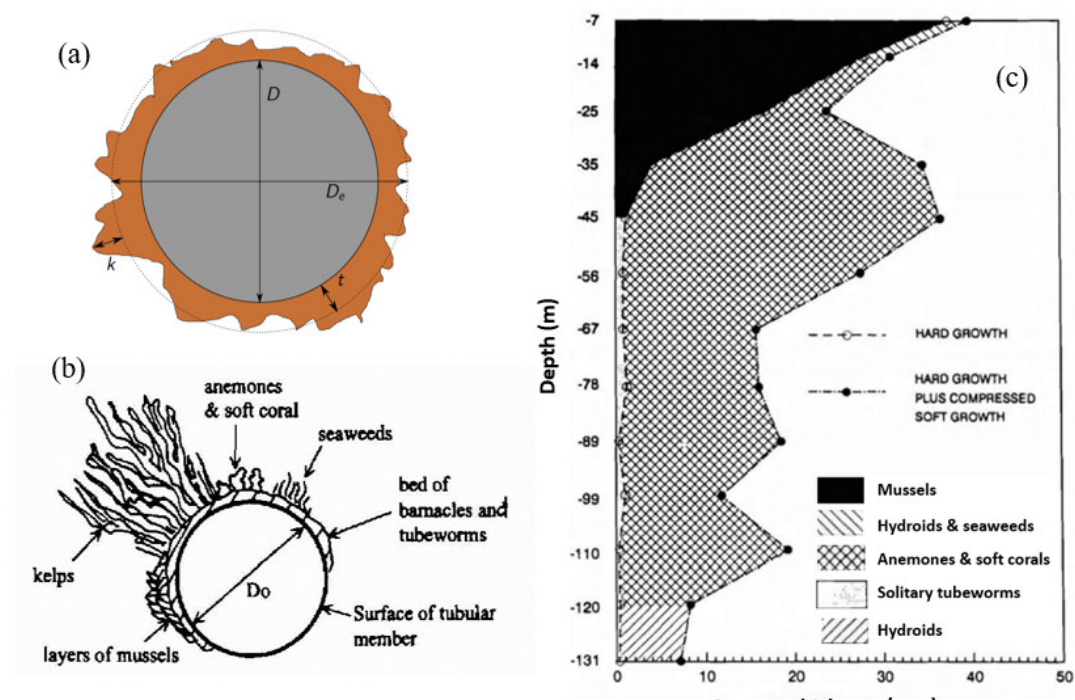
Figure 1. Modification of the external surface of a circular cylinder by biofouling, ( a ) definition of relative surface roughness by k : height and t : thickness, ( b ) schematic view of soft and hard biofouling (adapted from [8]), and ( c ) thickness variation pattern with the indication of the vertical distribution for North Sea (adapted from [5]).